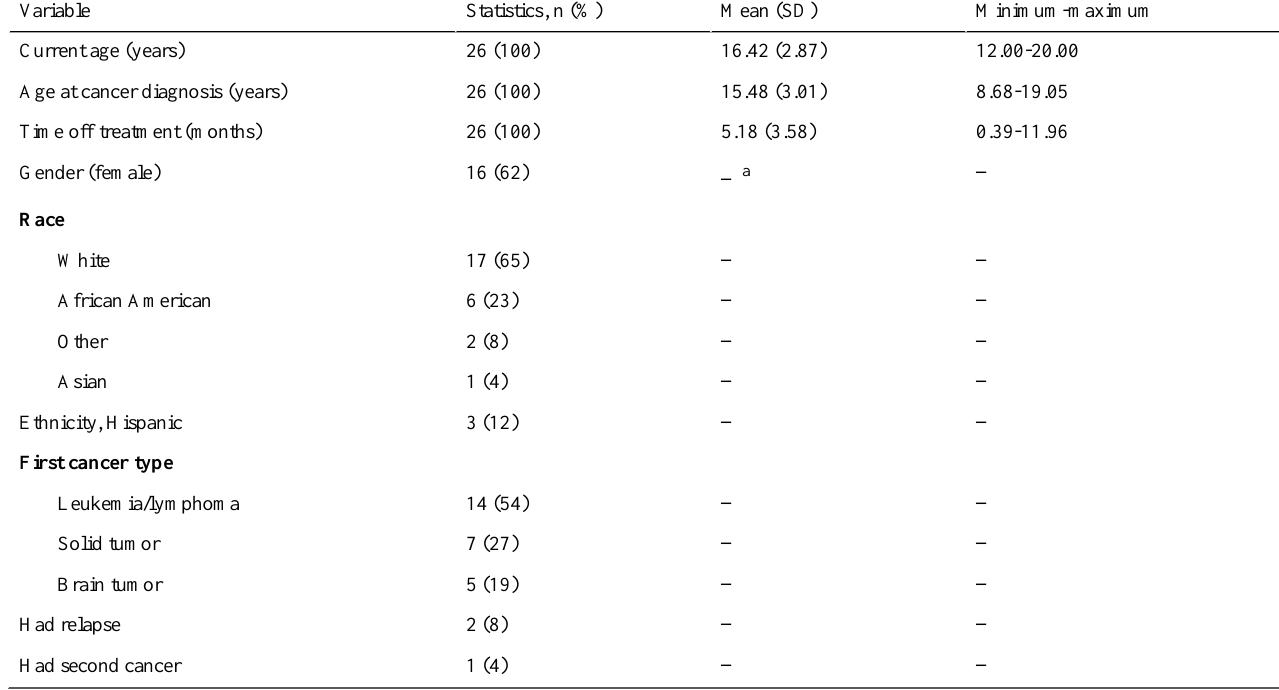
Table 2. Demographic and disease information